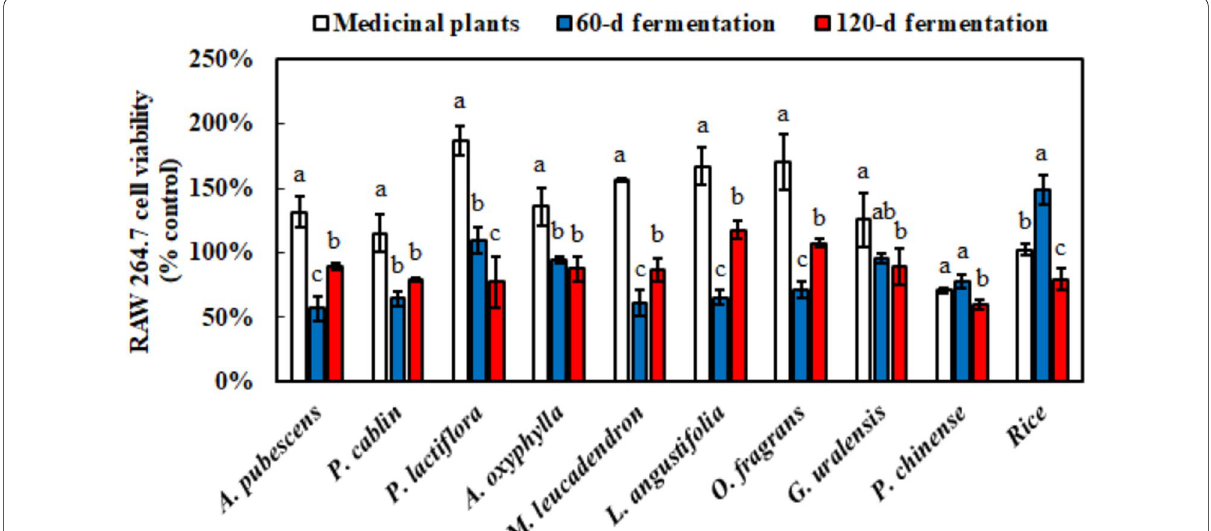
Fig. 3 Raw264.7 cell viability using MTT method with or without fermentation of medicinal plants at 0.5 mg/mL by M. ruber BCRC 31535. Results are mean S.D. (n 3) ± =